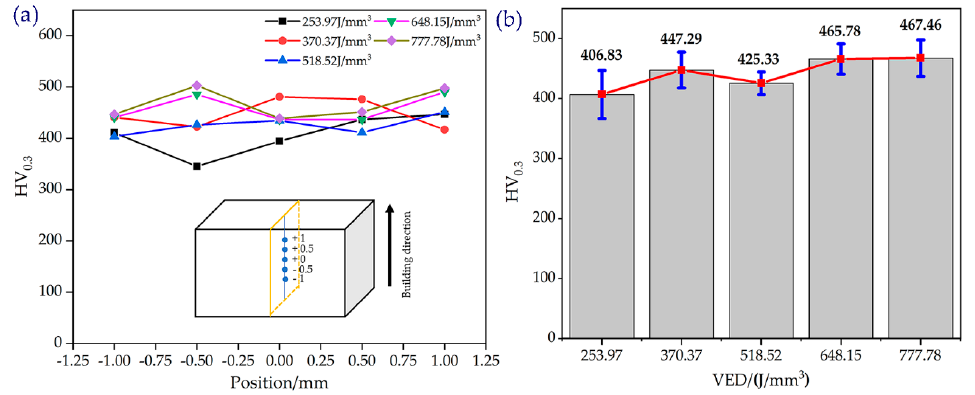
Figure 16. Microhardness under different VEDs. ( a ) Microhardness of each point; ( b ) average microhardness.